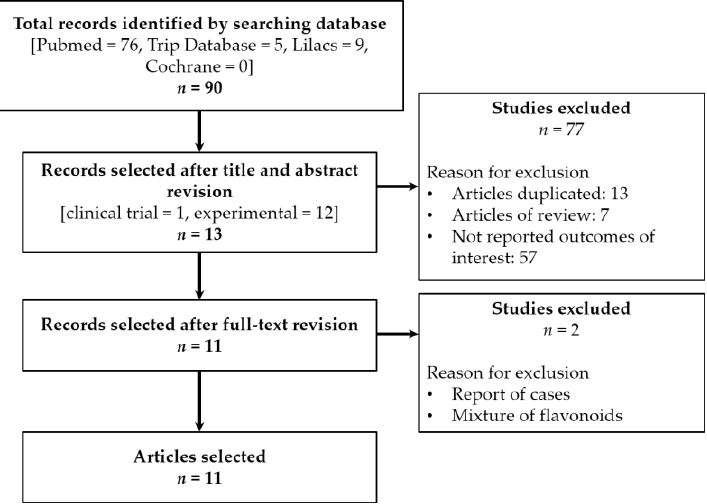
Figure 1. Flowchart showing the selection process for included studies on this systematic review.